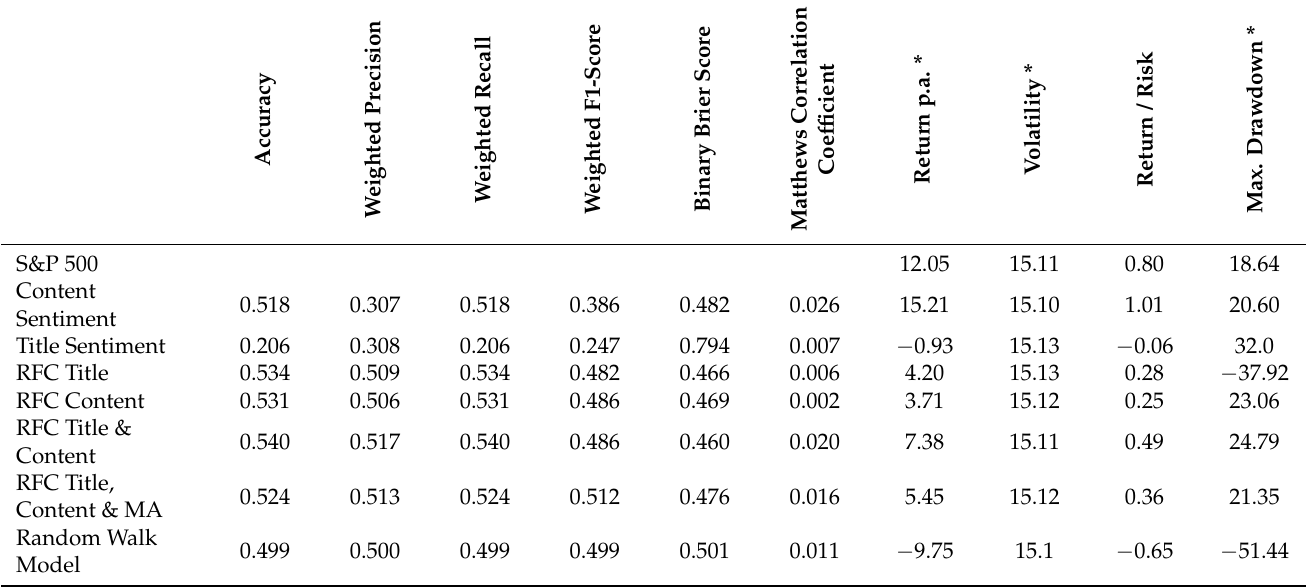
Table A2. Summary of empirical results, random forest classification optimized by the weighted